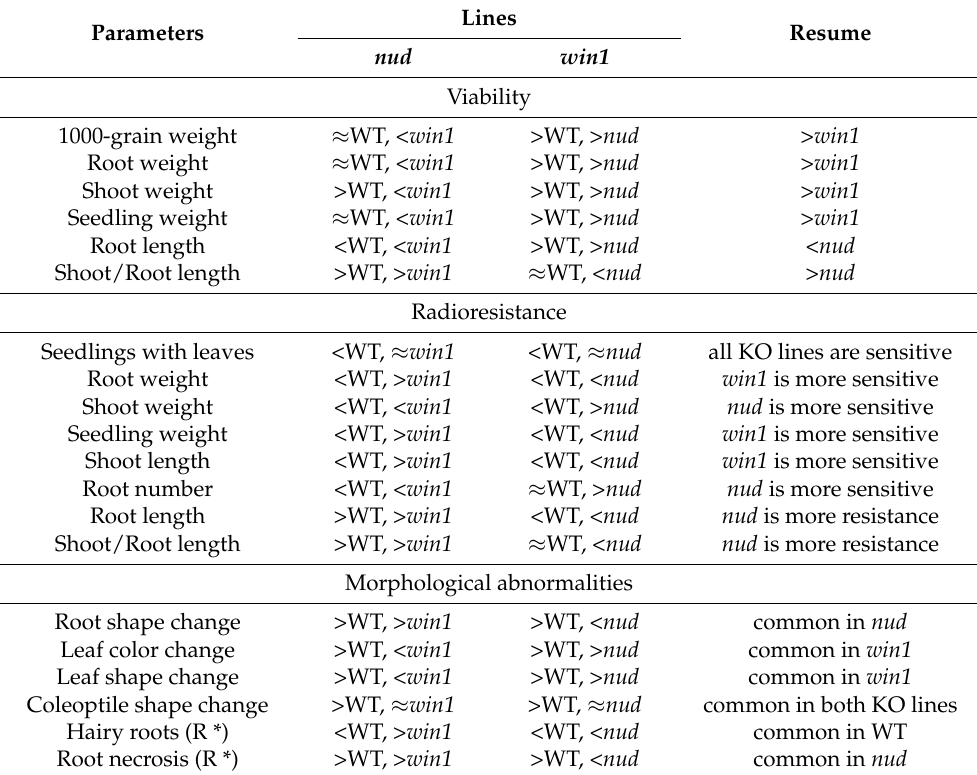
Table 3. Comparative evaluation of significant differences among barley KO lines in terms of viability, radiosensitivity, and seed mutability. Parameters